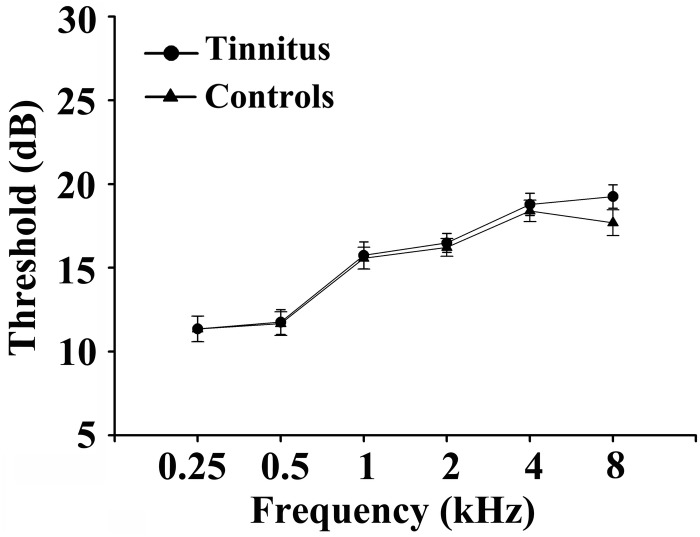
Mean hearing thresholds of the chronic tinnitus and control groups. Data are presented as mean ± SD.